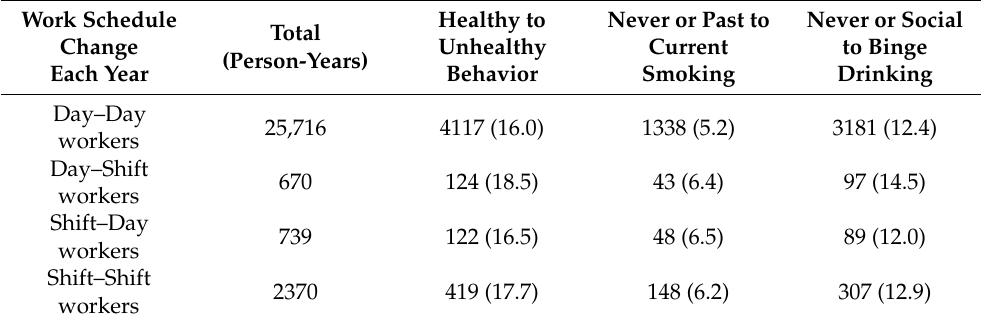
Table 2. Changes in smoking and drinking status according to changes in shift work schedule during the 14 year follow-up period (person-years, %).